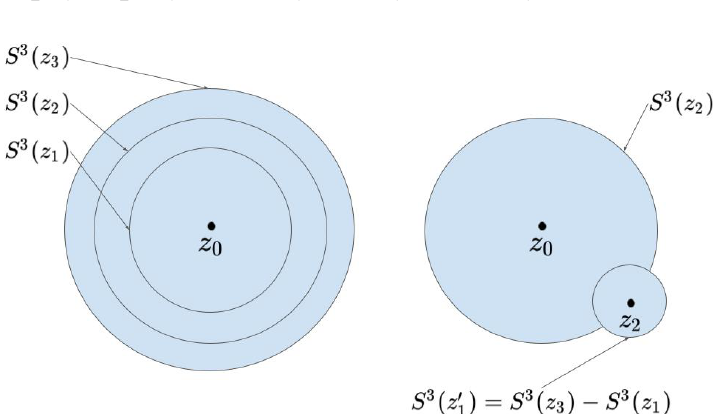
) is a 3-sphere embedded in (cid:67) i